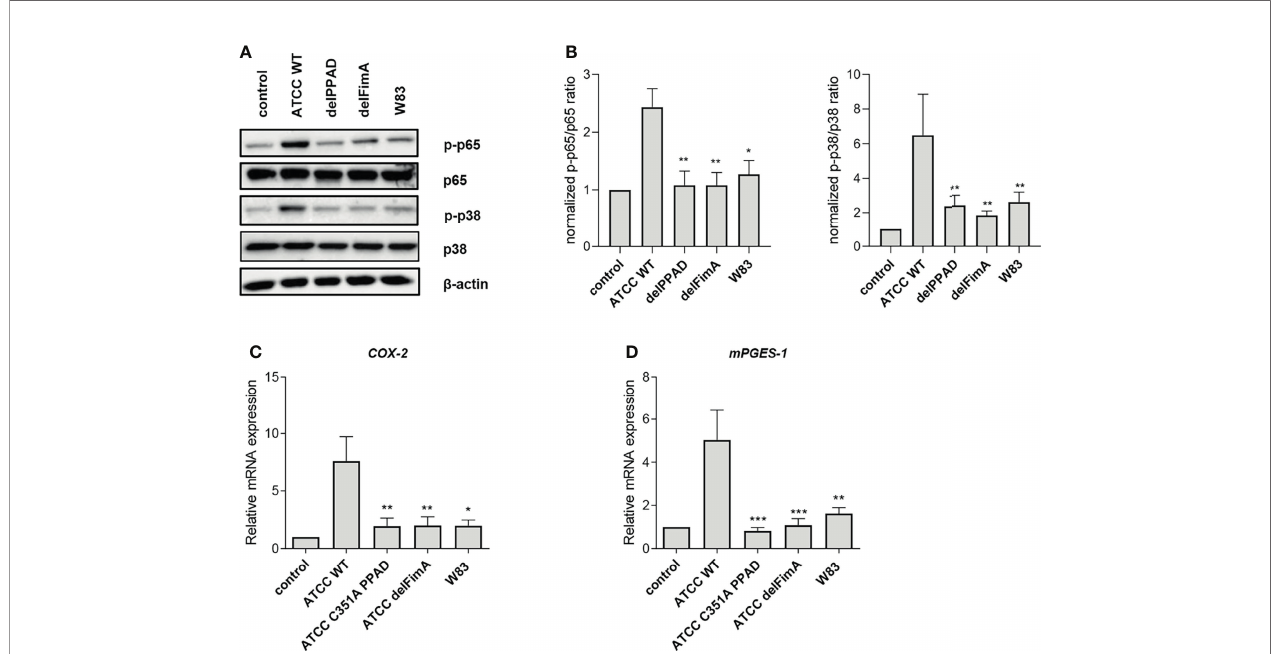
FIGURE 5 | Activation of the NF- ĸ B and MAPK kinase pathways, and expression of PGE2 synthesis pathway-related genes, are induced by citrullinated, fi mbriated P. gingivalis in PHGFs. PHGFs were infected for 1 h with the WT ATCC 33277 strain (ATCC WT) and its isogenic PPAD (delPPAD) and FimA mutants (delFimA), or the WT W83 strain at an MOI=20. (A, B) Western blot analysis was performed to detect total and phosphorylated p65 and p38. b -actin was used as a control. (A) Representative blots and (B) densitometry analysis of n=4 independent experiments is shown as the mean ± SEM. Relative mRNA expression of PGE2 synthesis-related genes (C) COX-2 and (D) mPGES-1 in PHGFs (n=10) infected with various P. gingivalis mutants. Cells were infected for 24 h at an MOI=100. Data represent the mean ± SEM (B) normalized phosphorylated to total protein ratio or (C, D) relative mRNA expression; ***p < 0.001; **p < 0.01; *p < 0.05; 1-way ANOVA followed by Tukey ’ s multiple comparisons test; data from the ATCC 33277 strain were compared to all other strains; “ n ” represents the number of independent experiments performed on PHGFs cell lines derived from different healthy